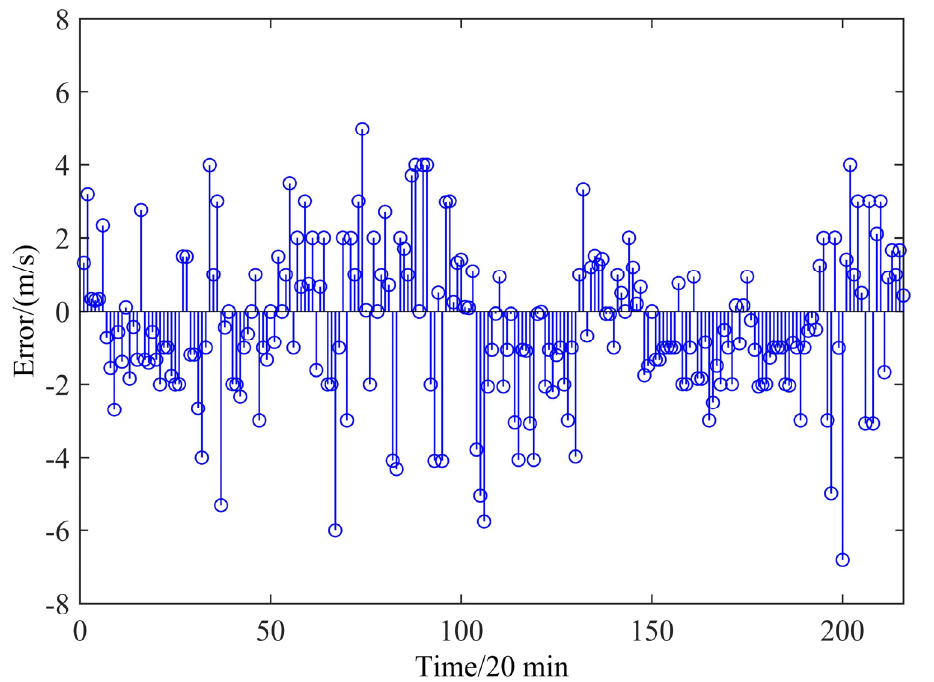
Figure 9. The error of